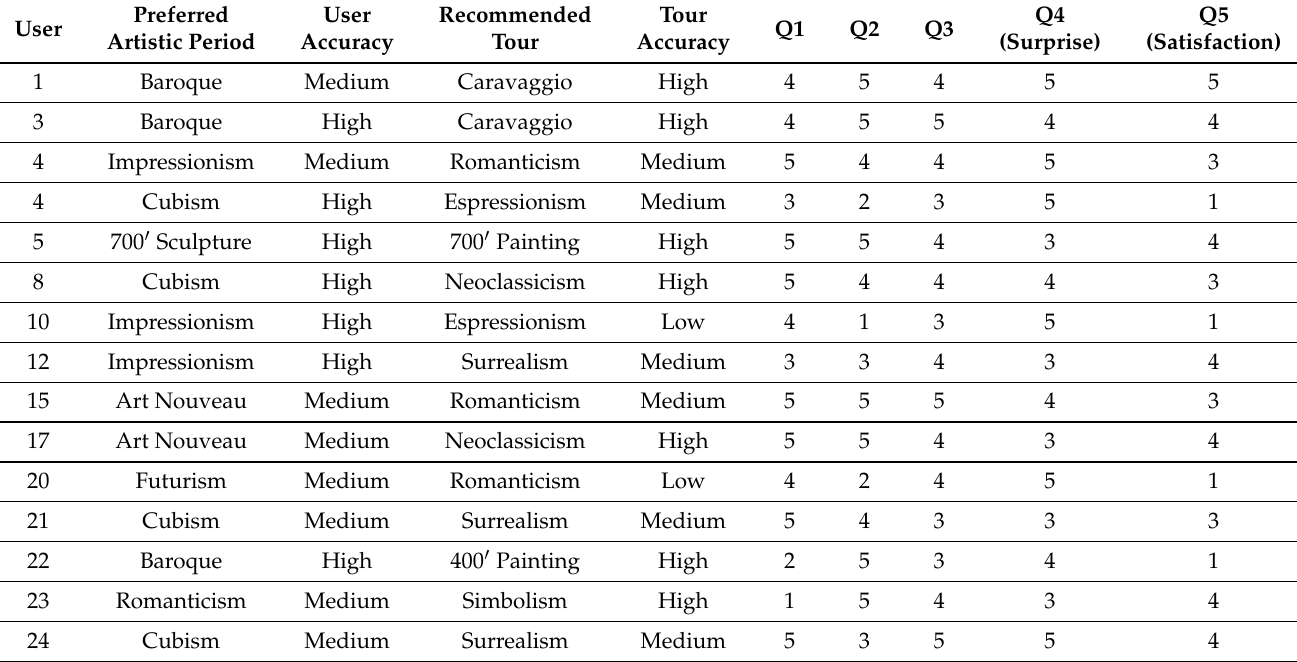
Table 1. This table reports the answers to the questions in the survey proposed by the robot after it provides critical help to the user. In these cases, the robot recommends a tour slightly different from the artistic period the user indicated as preferred in the history of art.